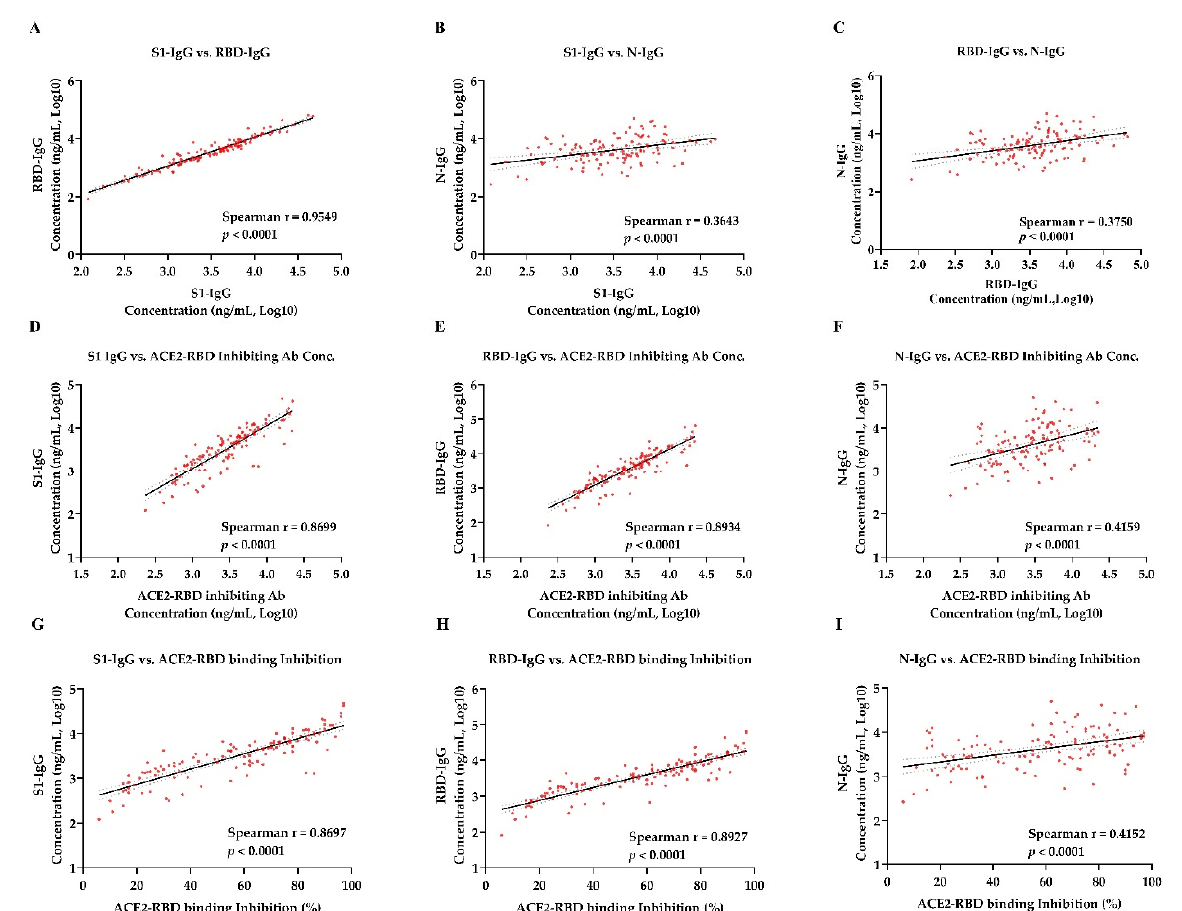
Figure 3. Correlation of ACE2-RBD inhibition assay and SARS-CoV-2 specific IgG concentration tests in 119 convalescent samples. ( A ) Correlation of S1-IgG and RBD-IgG. ( B ) Correlation of S1-IgG and N-IgG. ( C ) Correlation of RBD-IgG and N-IgG. ( D – F ) Correlation of ACE2-RBD inhibiting antibody concentration and S1-IgG, RBD-IgG, N-IgG. ( G – I ) Correlation of ACE2-RBD binding inhibition were computed by nonparametric spearman correlation. Spearman r > 0.7 and p value < 0.05 indicate a strong correlation, Spearman r < 0.7 and p value < 0.05 indicate a weak correlation, while p value > 0.05 indicate no correlation. The solid line represents a linear regression, with 95% confidence intervals represented by dotted lines.